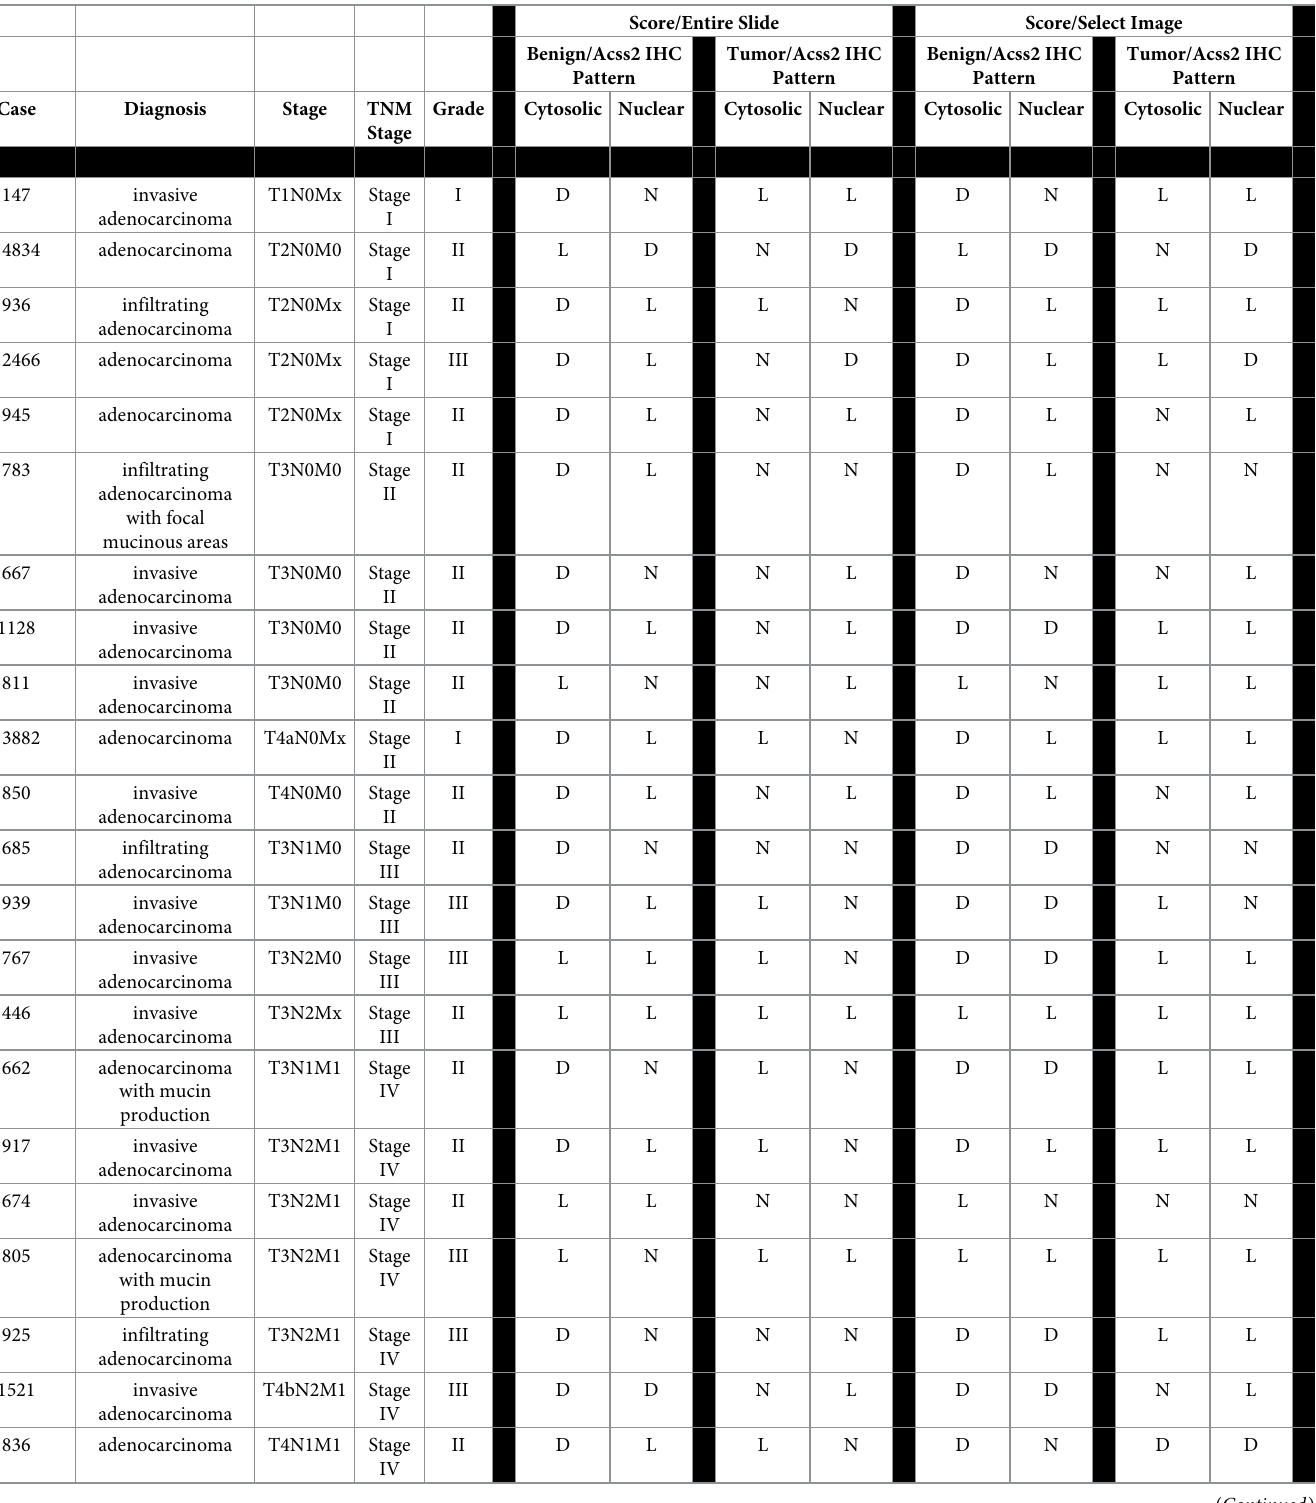
Table 2. Acss2 immunoreactivity exhibits distinct patterns in colon cancer